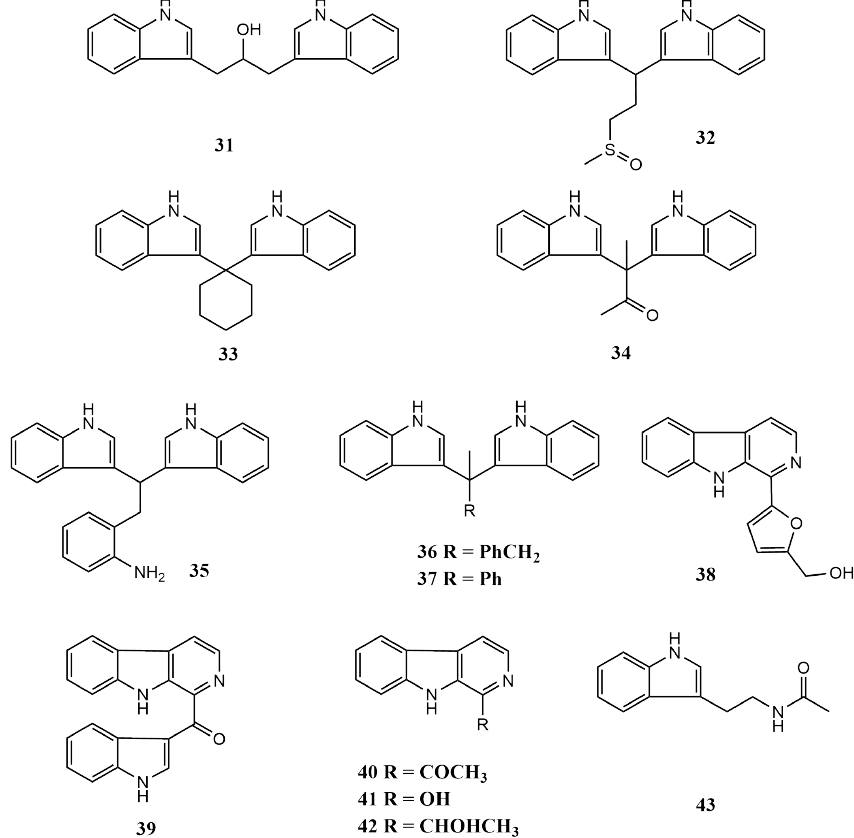
Figure 3. The chemical structures of the indoles of type isolated